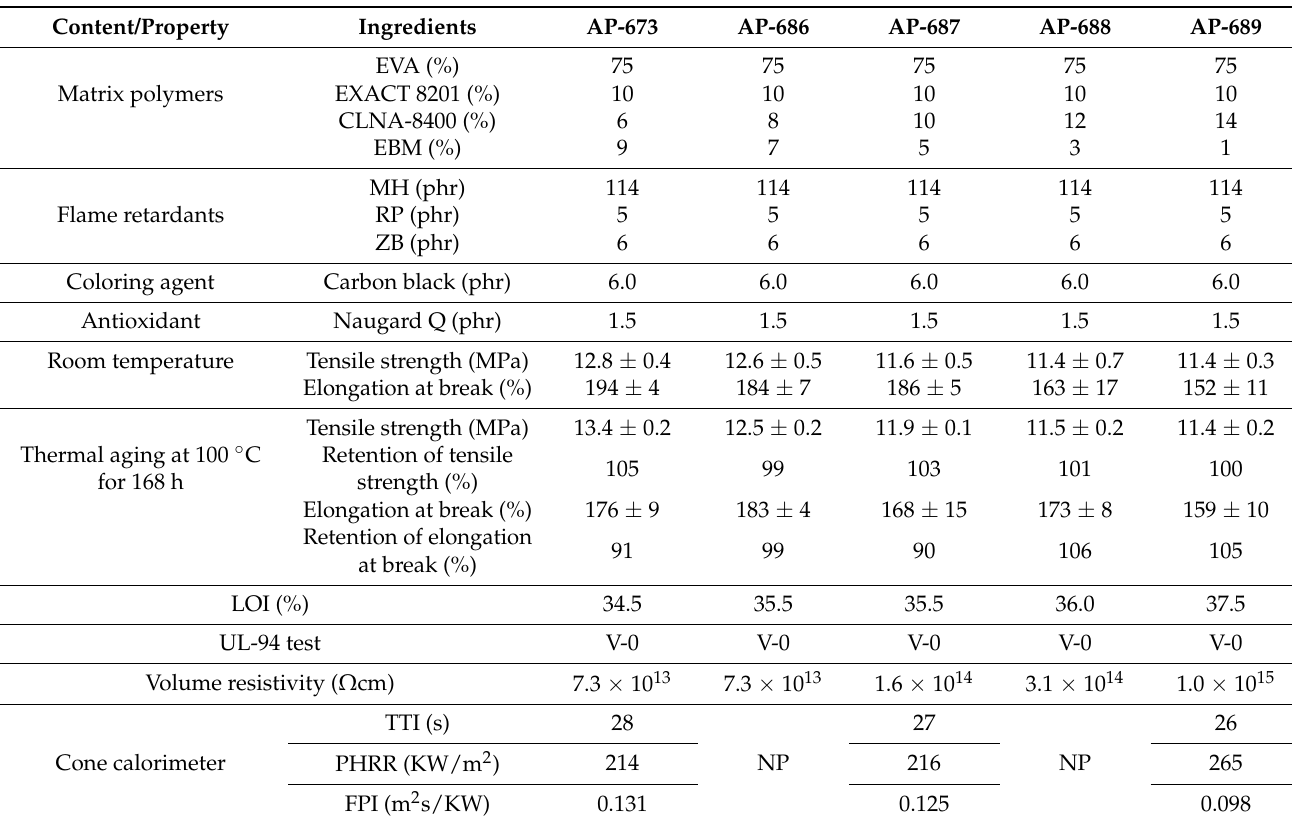
Table 4. EVA/EXACT 8201/CLNA-8400/125 phr flame-retardant (MH+ZB+RP) formulations as a function of EBM content